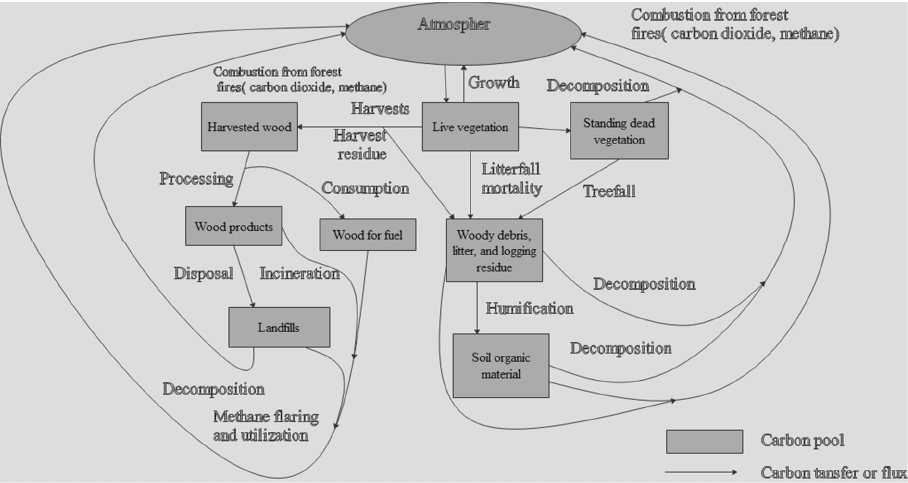
Figure 5. Sequestration cycle for forest carbon from the Inventory of US Greenhouse Emissions and Sinks. Source: Ingerson., et al. (2007)